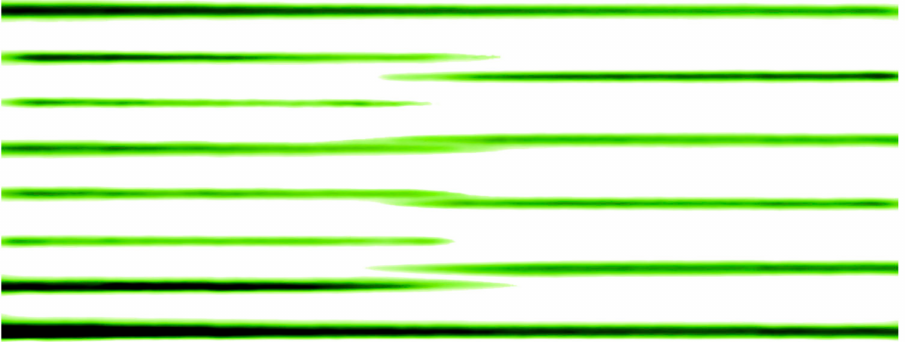
Figure 7. Profile of intensity of diffraction pattern from the germanium layer on Si(111) during the transition from the 7 × 7 to 5 × 5